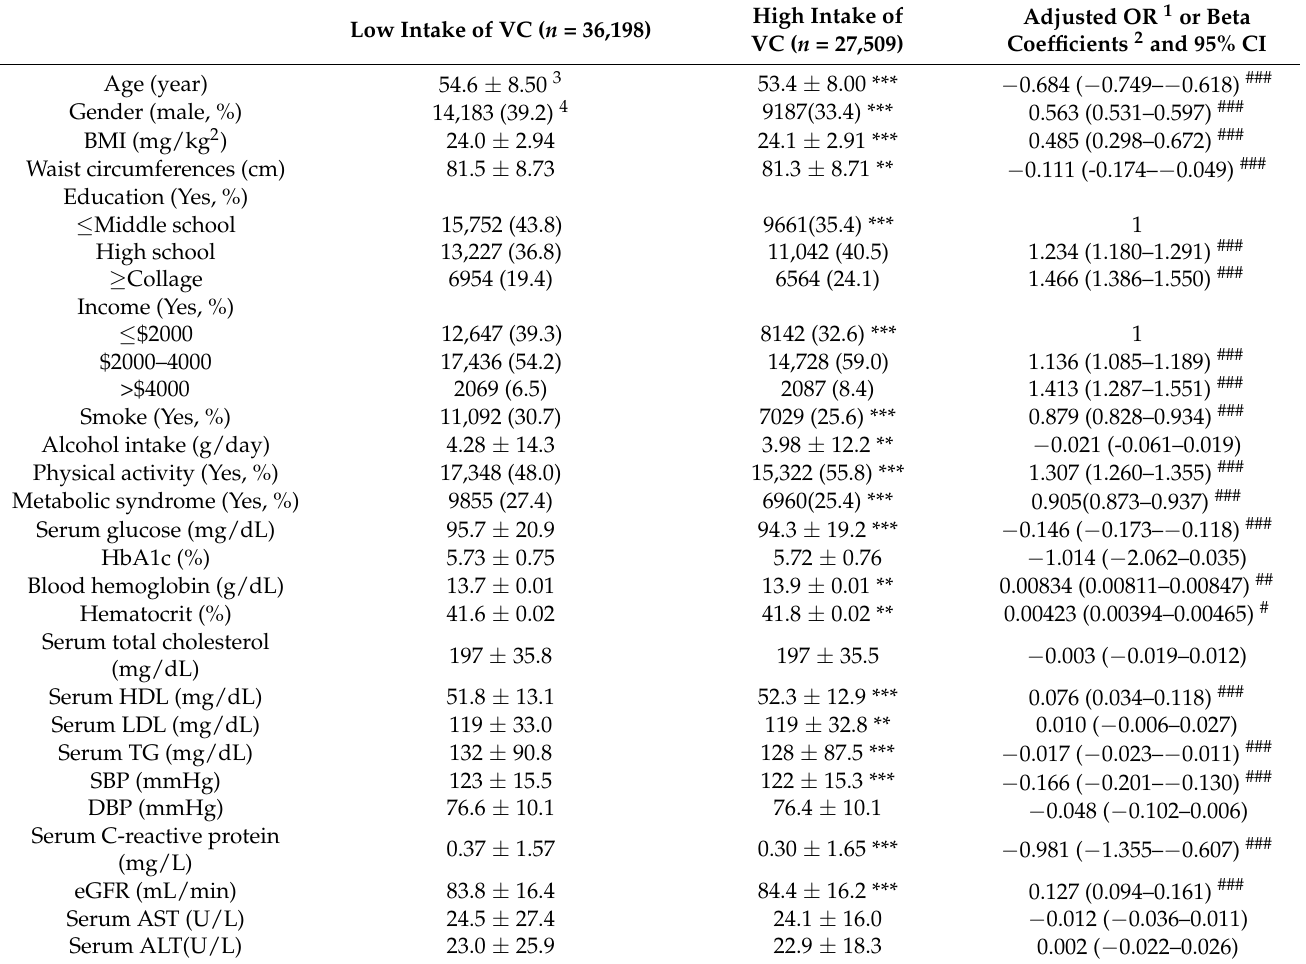
Table 1. Demographic and biochemical characteristics according to dietary vitamin C (VC) intake status and their association with the VC